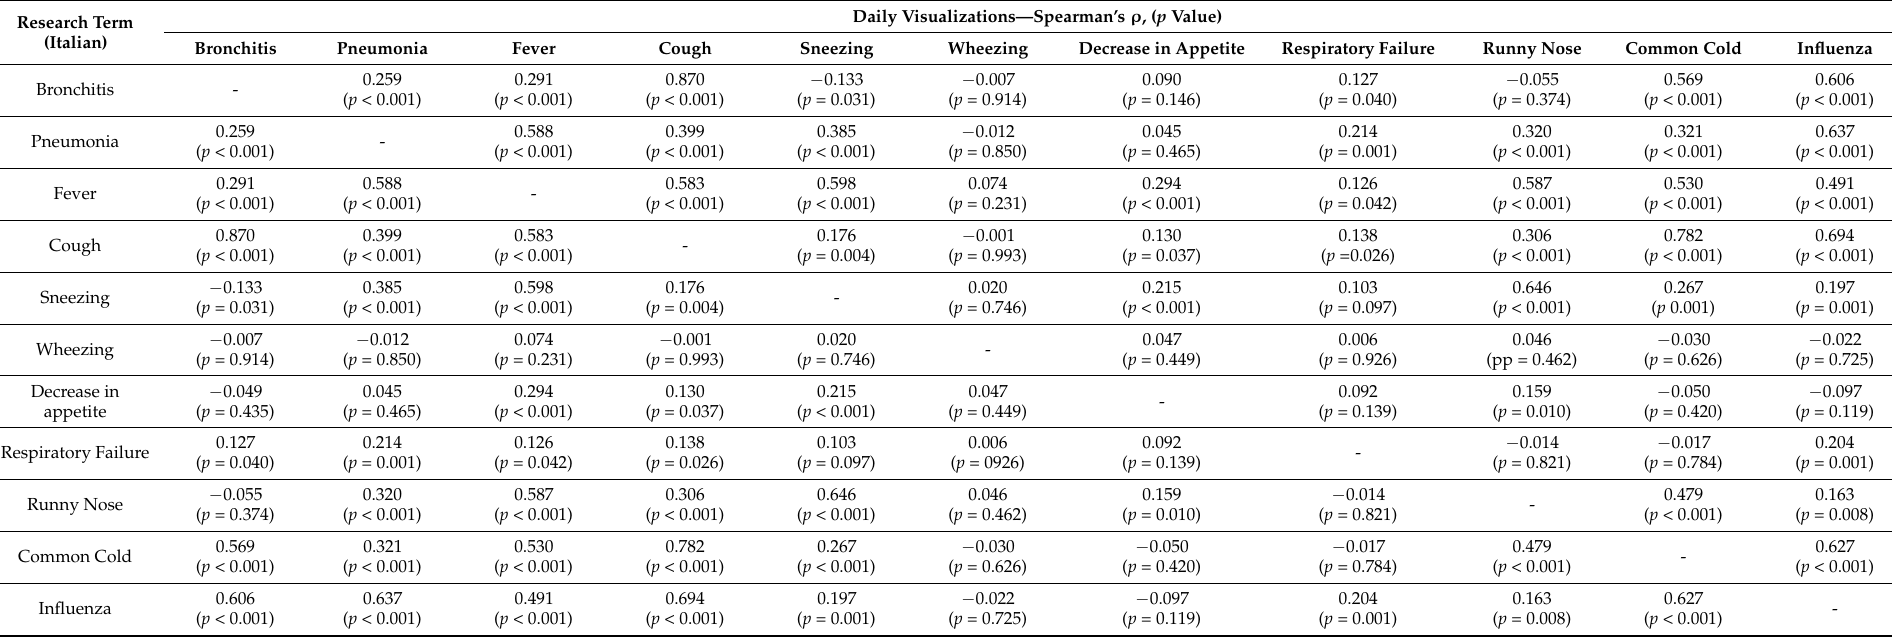
Table A2. Correlation between search volume for main Google Search